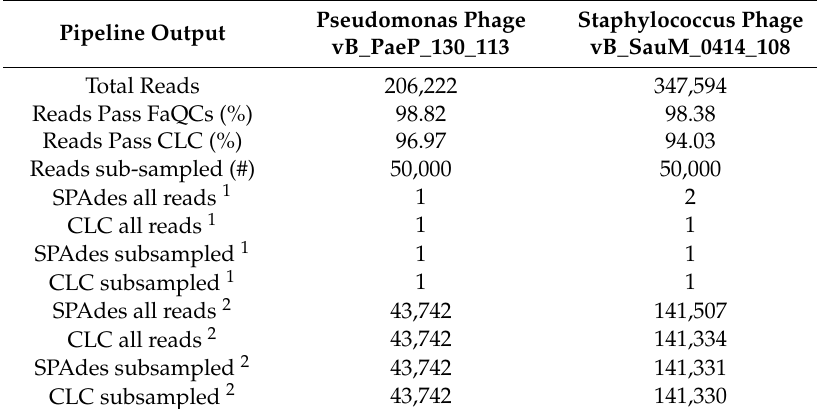
Table 2. Sequencing and Assembly